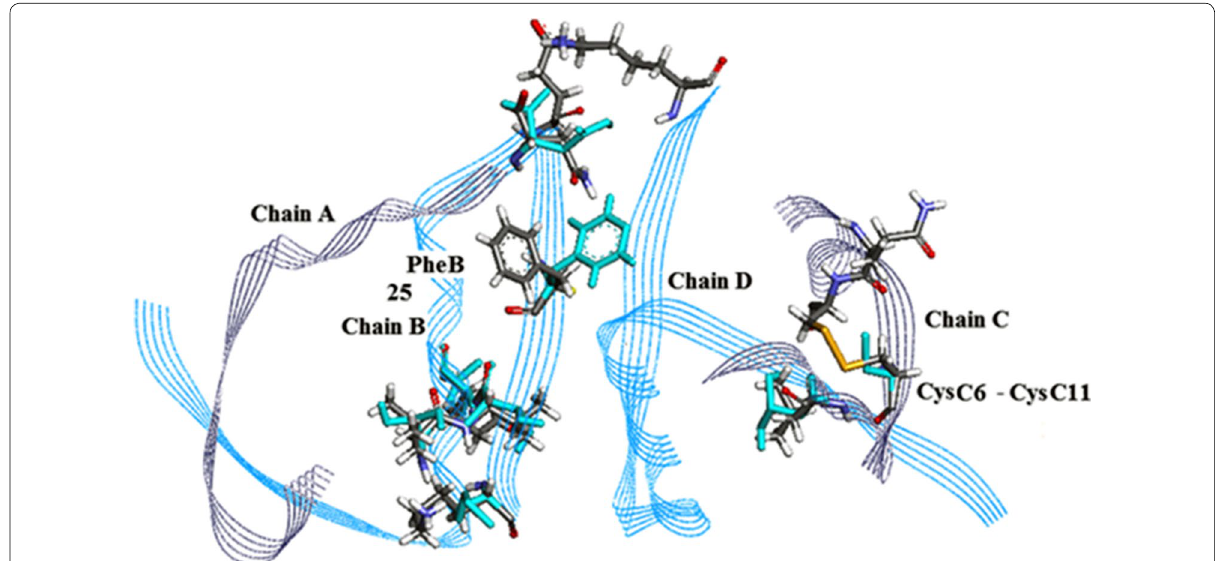
Fig. 12 Distribution of residues possibly associated with receptor binding and biological activity of HR insulin, Insugen (I). The major concentration of residues occurs on chain B ( blue ) which includes the residue Phe25B discussed in the definitive account of the porcine insulin X‑ray structure by Baker et al. [1]. In the Insugen (I) structure Phe25B occupies two distinct well defined conformations as shown here. It is of interest to note that in Intergen (II) HR insulin Phe25B has a clear well defined conformation. Alternative conformations in Insugen (I) residues are coloured blue here. A minor group of residues occurs on chain C (coloured grey ). Drawn with Accelrys Discovery Studio 3